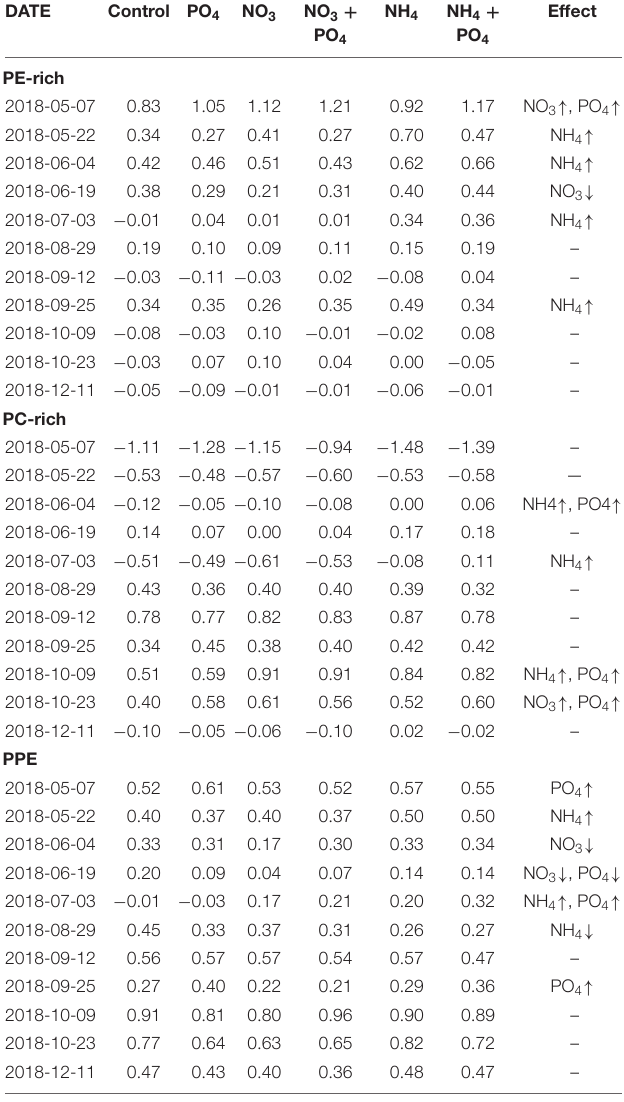
TABLE 1 | Bioassay average apparent net growth rates (day − 1 ) on each date and treatment for PE-rich (day − 1 ), PC-rich (day − 1 ), and PPE (day − 1 ) calculated from cell abundances measured using flow cytometry at T0 and